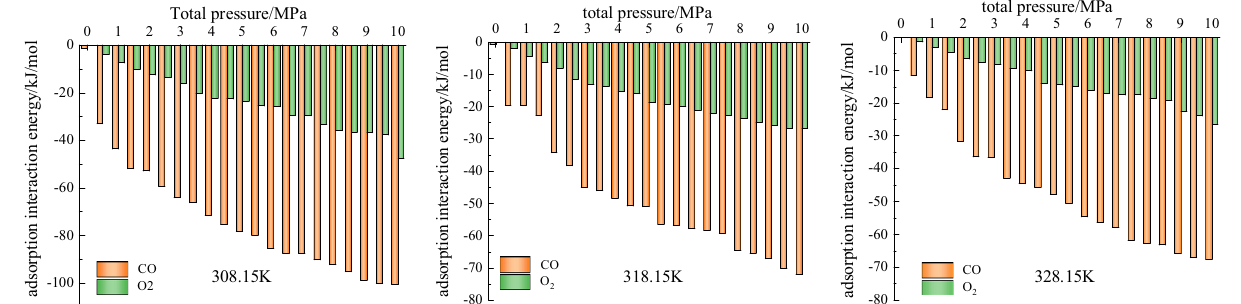
Figure 8. Functional relationship between the single-component gas adsorption energy and total pressure at different temperatures.